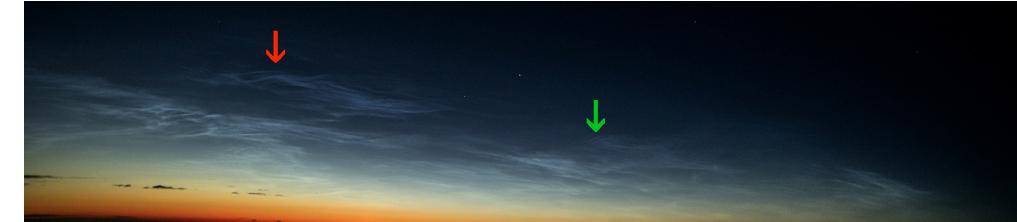
Figure 7. The SONC balloon image taken at 6222m above the ground at 21:49UT on 5 July 2018. The red arrow marks the vertical modulation of the NLC layer by a gravity wave of medium scale. The green arrow indicates small-scale billow-type gravity waves.